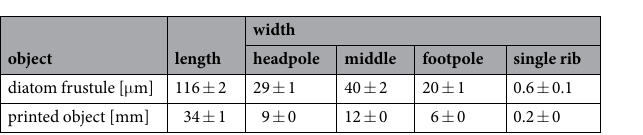
Table 1. The mean values and standard deviations of sub-structures of D. geminata